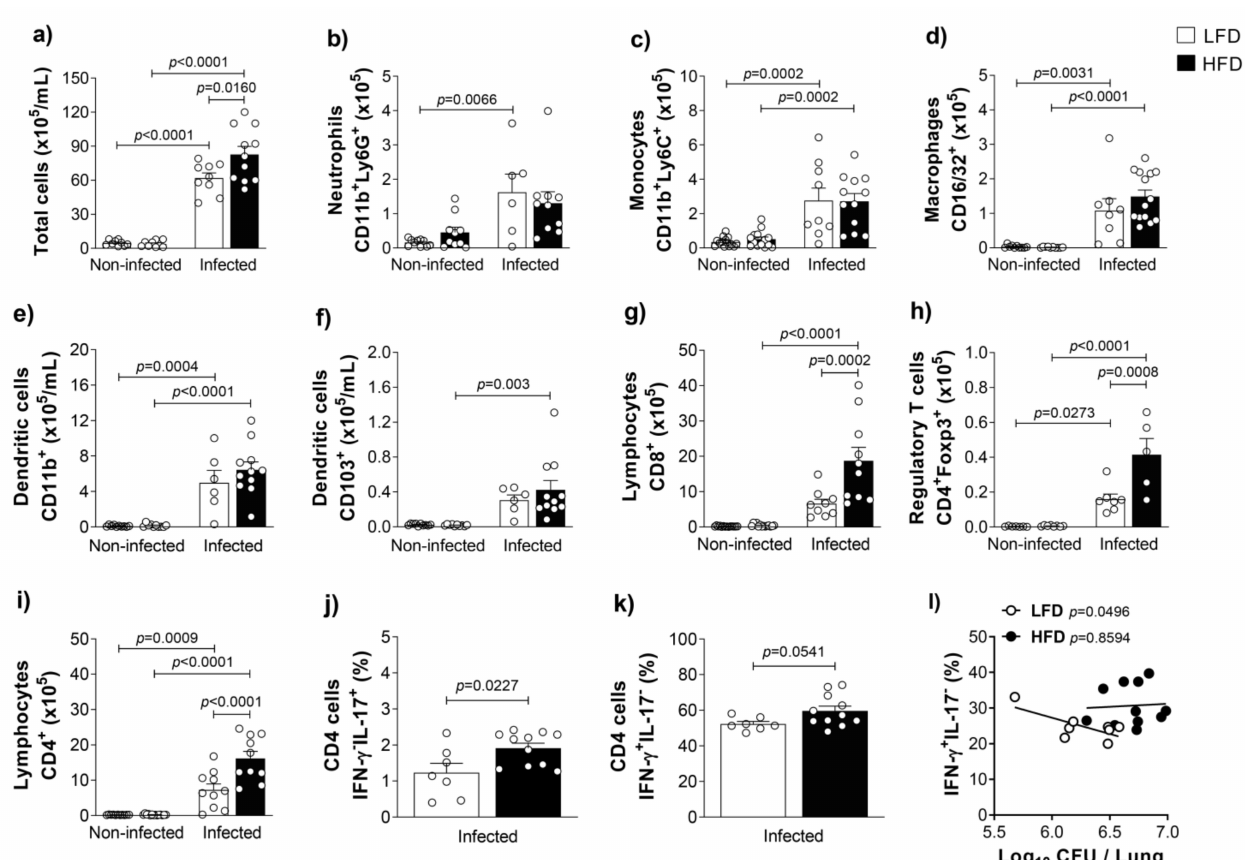
Figure 2. M. tuberculosis infection increases lung leukocyte infiltration in obese mice. C57BL/6 mice were fed with the LFD or HFD for 8 weeks and infected with M. tuberculosis by intra-tracheal (it) route. At 4 weeks post-infection (12 weeks of feeding), lungs were evaluated. ( a ) Total cells ( × 10 5 /mL) and cell number of ( b ) neutrophils, ( c ) monocytes, ( d ) macrophages, ( e ) dendritic cells CD11b + , ( f ) dendritic cells CD103 + , ( g ) lymphocytes CD8 + , ( h ) regulatory T cells Foxp3 + , ( i ) lymphocytes CD4 + , ( j ) IL-17-producing CD4 cells and ( k ) IFN- γ -producing CD4 cells in the lungs of lean and obese mice infected or not with M. tuberculosis ( n = 6–14/group). ( l ) Correlation between CFU number and CD4 + IFN- γ + IL-17 − cells ( n = 8–11). Data are representative of two independent experiments and are expressed as means ± SD. Bars show the significant difference between groups ( p <